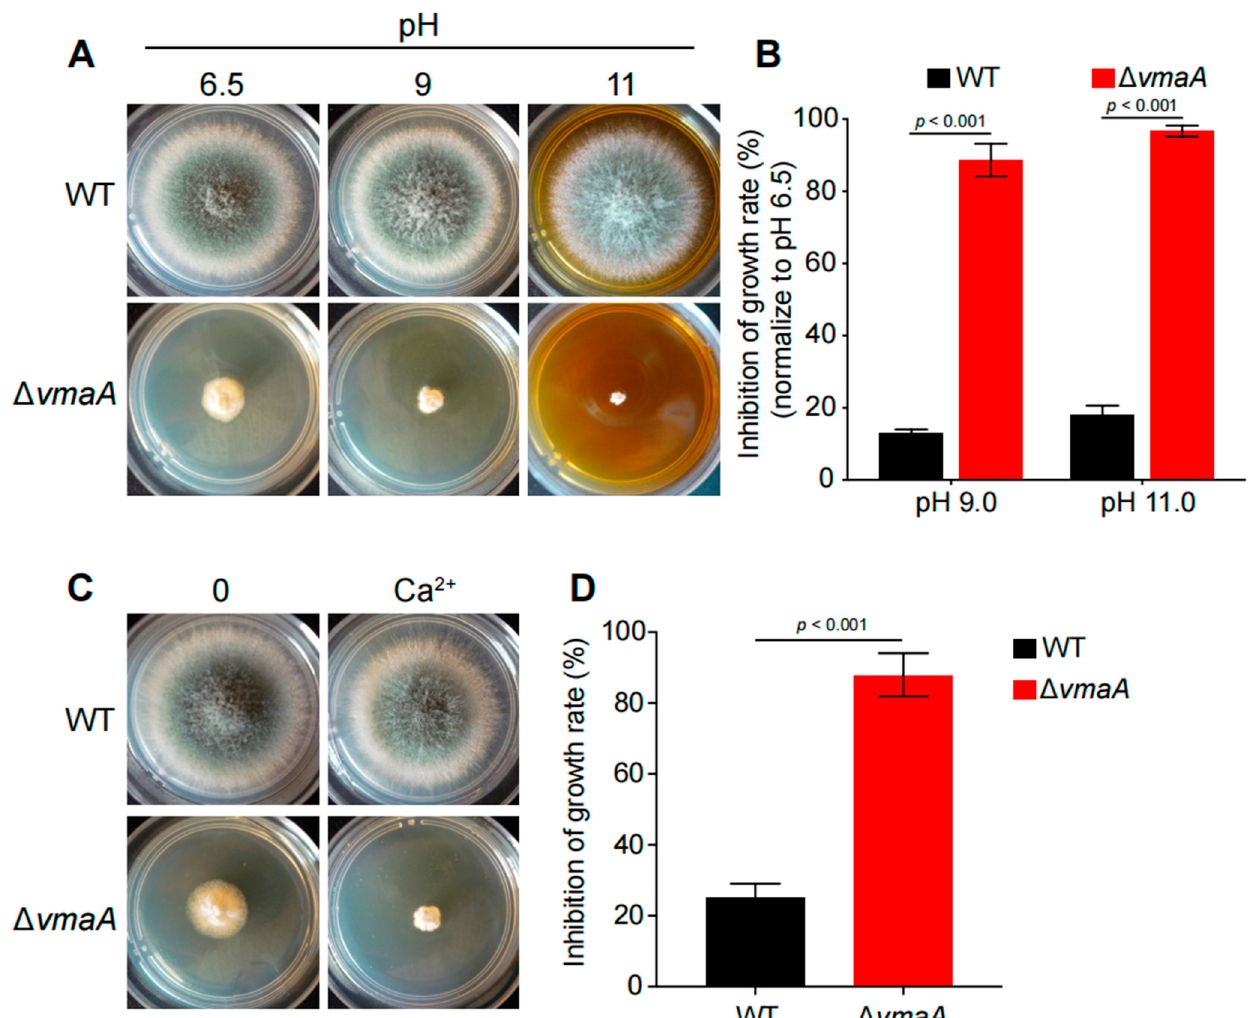
Figure 4. VmaC is a subunit of the V ‐ ATPase complex. ( A ) The morphology of mycelial pellets of the wild ‐ type and Δ vmaA strains under different pH 6.5, pH 9, and pH 11 conditions. ( B ) The growth inhibition rates of Δ vmaA when treated with pH 9 and pH 11. ( C ) The morphology of mycelial pel ‐ lets of the wild ‐ type and the Δ vmaA strains in 500 mM calcium stimuli. ( D ) The growth inhibition rates of Δ vmaA when treated with 500 mM